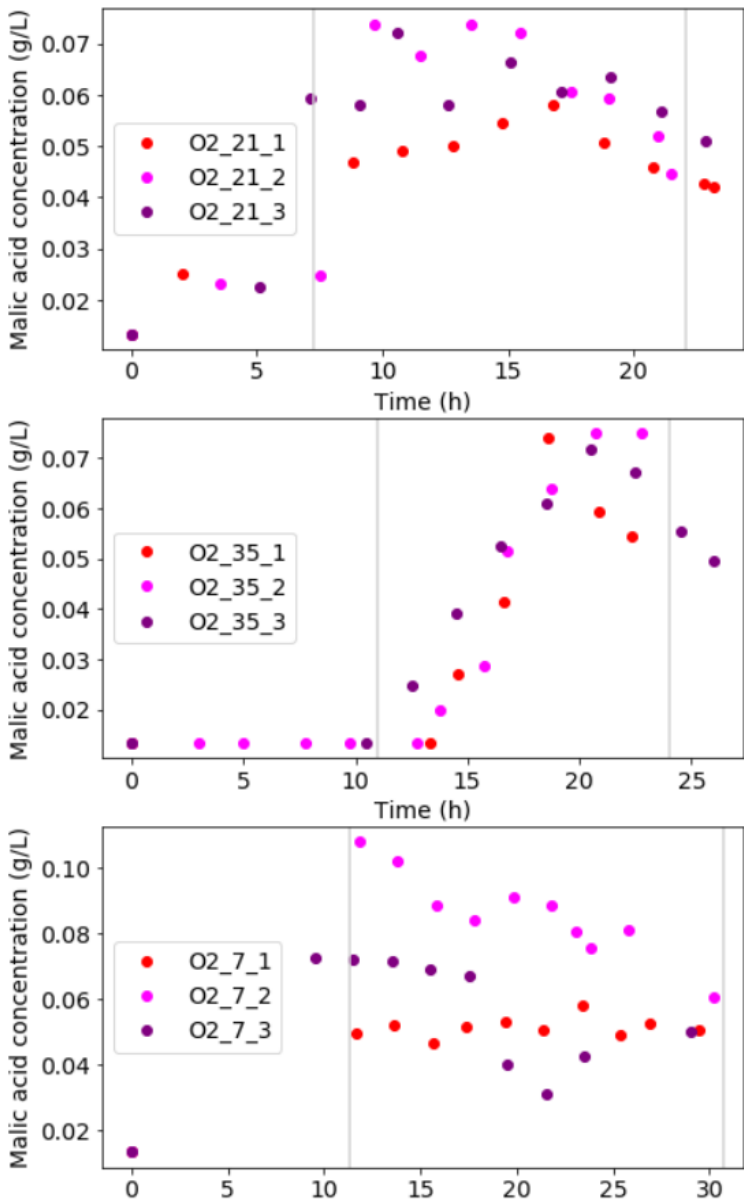
Figure 4. Malic acid concentration profiles for each experimental condition show relatively high malic acid is attained in each run. Slight decreases in malic acid are visible towards the end of an experimental run, where glucose is near to